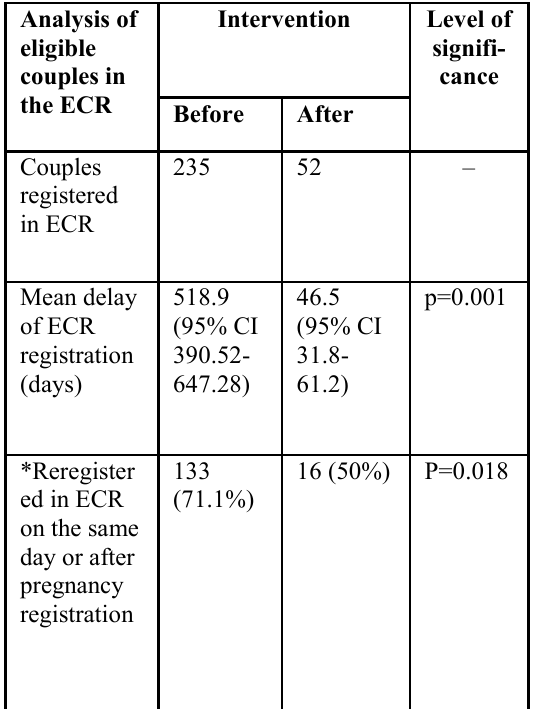
Table 01: Analysis of ECR before and after the intervention